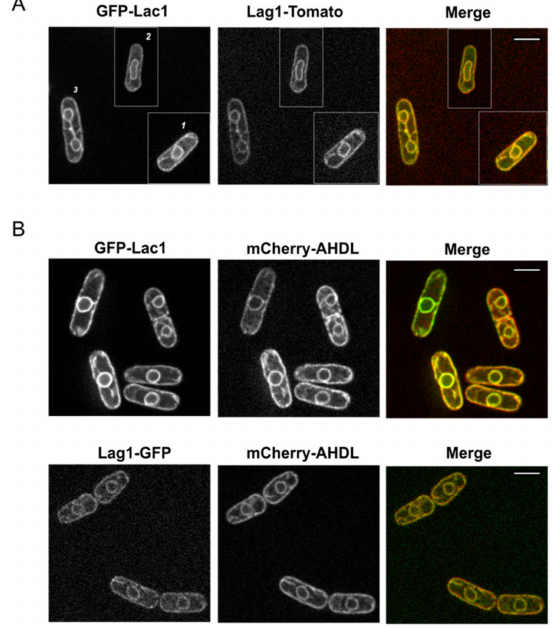
Figure 2. Ceramide synthase complex is localized at the endoplasmic reticulum. ( A ) Wild-type cells expressing GFP-Lac1 and Lag1-Tomato were grown to early log-phase in YES media and visualized by using live-cell imaging. Image shows a composite of three representative cells in G2 (cell 1), early mitosis (cell 2) and late mitosis (cell 3). ( B ) Representative wild-type log-phase cells expressing the endoplasmic reticulum marker mCherry-AHDL with GFP-Lac1 (upper panel) or Lag1-GFP (lower panel). Scale bar is 5 µ m for all the images.